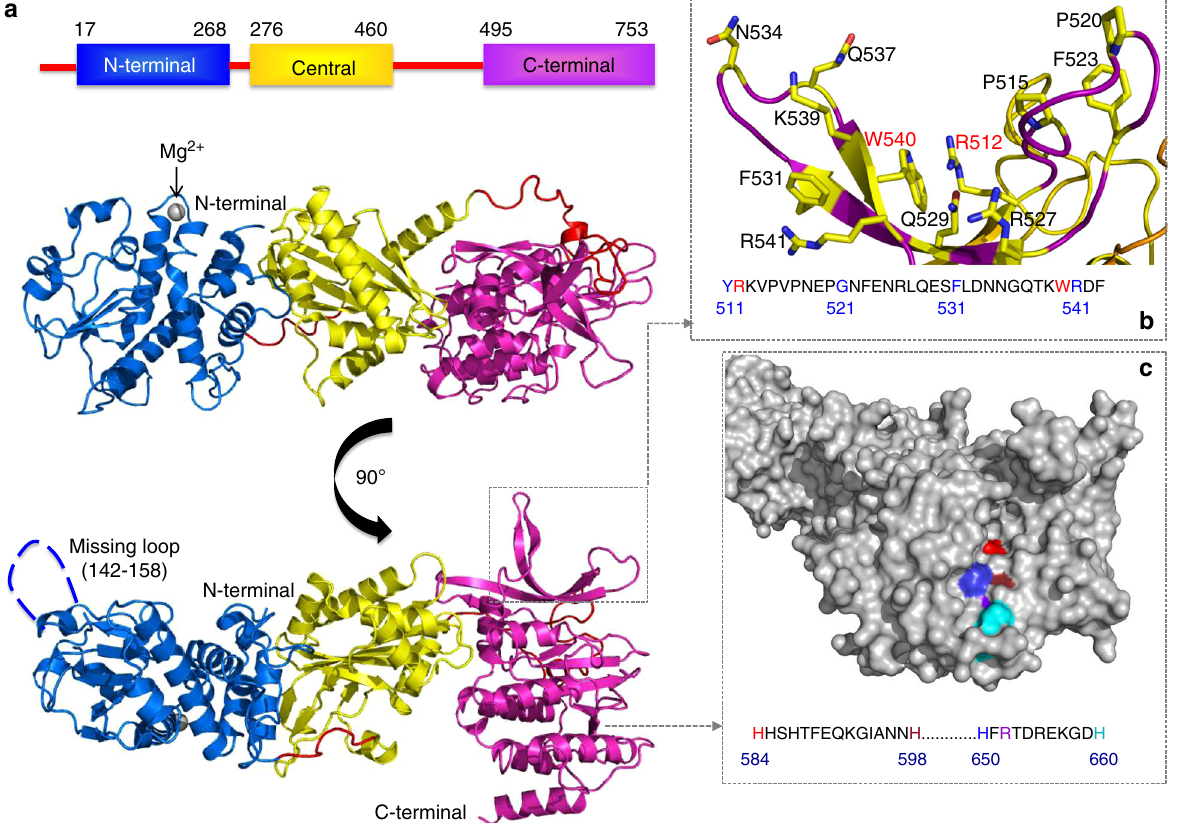
Fig. 3 Ribbon representation of the overall 3D structure of the nigritoxin molecule. The polypeptide chain is color-coded following the domain architecture (blue: N-terminal; yellow: central; magenta: C-terminal; domains) schematically represented in the upper panel of a . The central panel highlights the 3D domain organization observed in the crystal structure, revealing the Mg 2+ bound to a surface loop of the N-terminal domain and the linker regions (orange) (see also Fig. 4). The lower panel displays the 3D structure turned by 90° around the horizontal axis, showing a disordered loop in the N-terminal domain for which no electron density is visible in the crystal structure. The overall fold as well as those of the three individual domains do not superimpose to any known structure when submitting a “ blast against PDB ” . b Close-up view of a particular structural feature present in the C-terminal domain, which is formed by two loops projecting into the solvent region. The arginine (R512) and tryptophan (W540) residues that stack against each other, as well as some selected residues pointing toward the exterior of the protein are highlighted in stick representation. c Surface representation of the C-terminal domain (gray), highlighting a local groove, in which a series of histidine and arginine residues (surface color corresponds to the color of the residue in the sequence extract) form a large patch that could represent a region important for the biological function. The patch is localized in front of a cavity